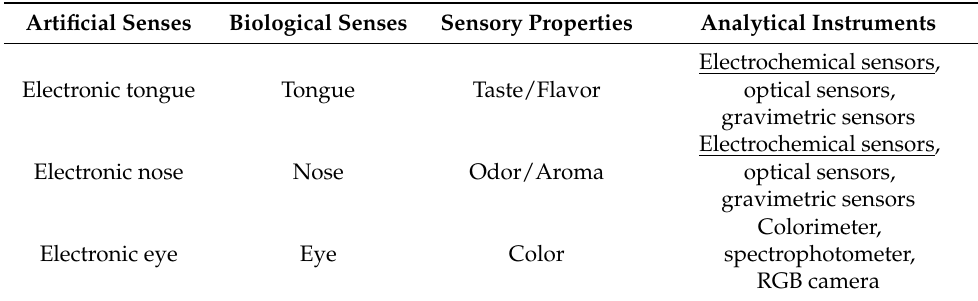
Table 1. Biological senses involved in food quality assessment and analytical instruments suitable to represent the corresponding artificial